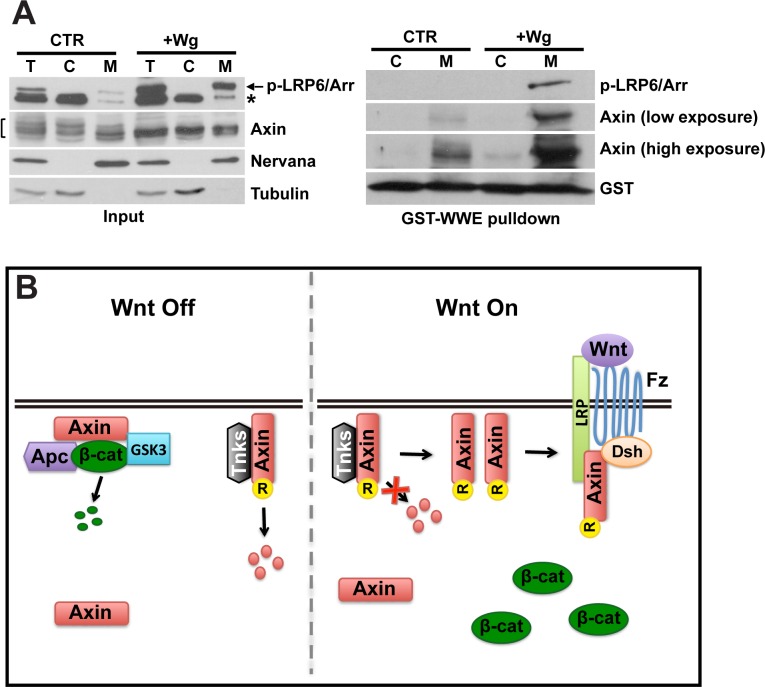
Wingless stimulation results in increased membrane-associated ADP-ribosylated Axin(A, left panel) Subcellular fractionation of lysates from S2R+ cells treated with either control medium (CTR) or Wingless conditioned medium (Wg CM) for 1 hour. The total cell lysates (T), cytoplasmic (C), and membrane (M) fractions were analyzed by SDS-PAGE. Immunoblotting with phosphorylated LRP6 antibody shows activation of the Wnt pathway following treatment with Wg CM. Immunoblotting with Axin antibody shows no significant shift from the cytoplasmic fraction to membrane fraction. Tubulin, a cytoplasmic marker, and Nervana, a membrane marker, were used to assay the efficiency of fractionation. Asterisk indicates a non-specific band with p-LRP6 antibody. (A, right panel) Following cell fractionation, GST-WWE pulldown was performed with cytoplasmic (C) and membrane (M) fractions. Immunoblotting with Axin antibody reveals that the majority of ADP-ribosylated Axin is in the membrane fraction, with little ADP-ribosylated Axin detected in the cytoplasm. Phospho-LRP6 is pulled down by GST-WWE in the membrane fraction in response to Wingless. (B) Model for dual roles of membrane-associated Axin. In the absence of Wnt stimulation, a pool of Axin is localized in membrane-proximal puncta, which might represent the sites of the destruction complex. Membrane-associated Axin is targeted for degradation by Tnks in the unstimulated state, which contributes to maintaining Axin at the limiting concentrations important for regulation of Wnt signaling. Wnt stimulation induces a rapid increase in the level of Axin, and in particular the membrane-associated ADP-ribosylated Axin pool. ADP-ribosylation enhances the interaction of Axin with phospho-LRP6/Arrow, and thus promotes the activation of signaling. R: ADP-ribosylation.